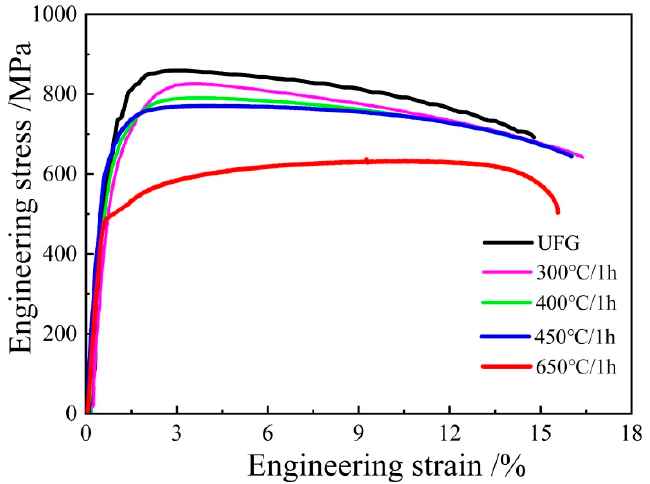
Figure 4. Engineering stress–strain curves of the UFG TiFeB alloy after isochronal annealing at different temperatures.